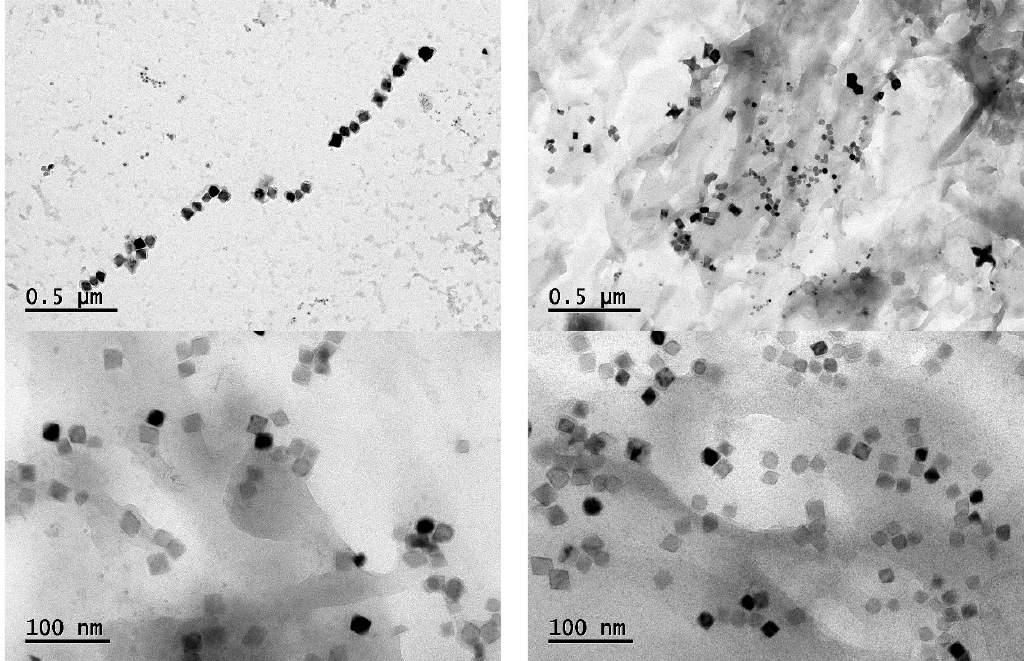
Figure 7. Distribution of precipitates.